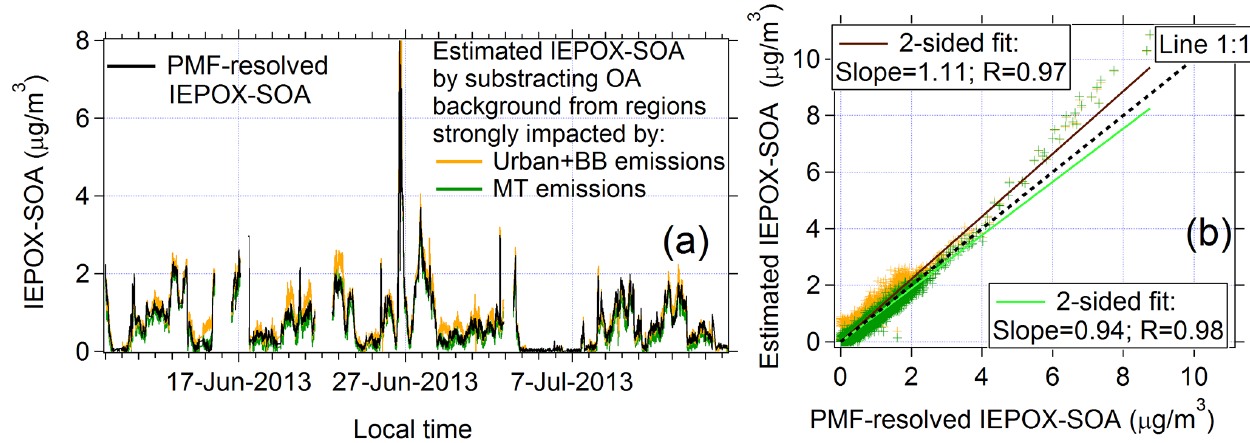
Figure A4. (a) Time series of IEPOX-SOA PMF and estimated IEPOX-SOA based on m/z 82 for the SOAS-CTR data in SE US forest. Two different estimates of background m/z 82 are shown, using values from regions strongly impacted by urban and biomass-burning emissions vs. regions with strong monoterpene emissions. (b) Scatter plot of estimated IEPOX-SOA vs. IEPOX-SOA PMF . Note that the largest IEPOX- SOA plume ( > 4µgm − 3 ) on 26 June 2013 had a slightly higher f OA of 24‰, resulting in a slight overestimation of IEPOX-SOA for those 82 data